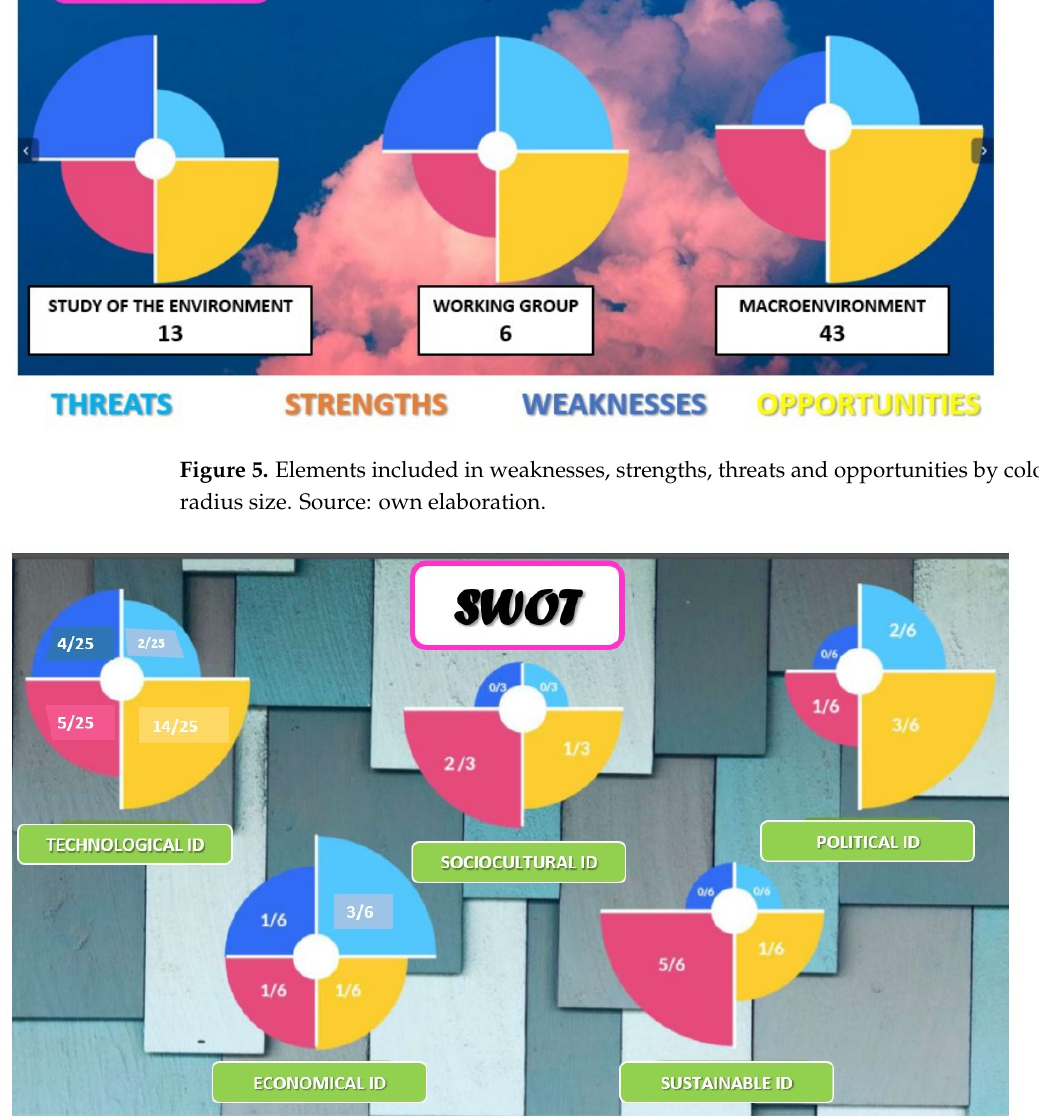
Figure 6. Percentage of indicators from each BOT block in each SWOT element. Source: own elaboration.